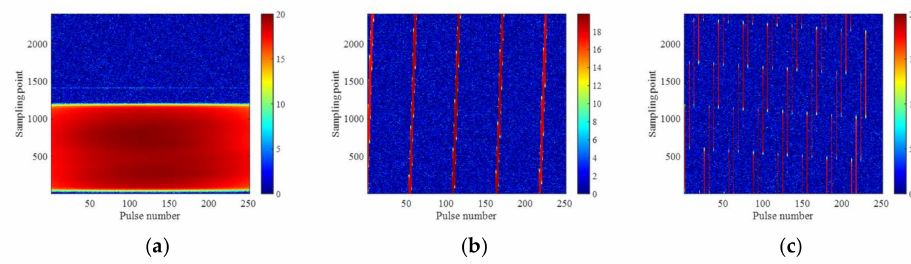
Figure 5. The obtained 2D reference signal matrices with ( a ) PRI = 593.18 µ s (IW 3), ( b ) PRI = 582.37 µ s (IW 1), and ( c ) PRI = 688.88 µ s (IW